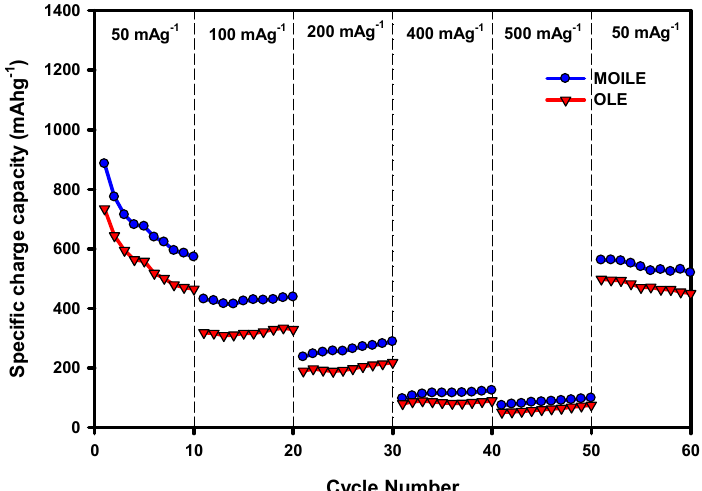
Figure 10. Rate performance (charge capacity vs cycle number at different current densities) of SnO 2 /C composite fibers at 25 °C with two different electrolytes: OLE (1M LiPF 6 in EC/DMC (1:1 v/v)), and MOILE (1 M LiTFSI in 60% EMI-TFSI/ 40% EC/DMC (1:1 v/v) with 5 wt% SN).